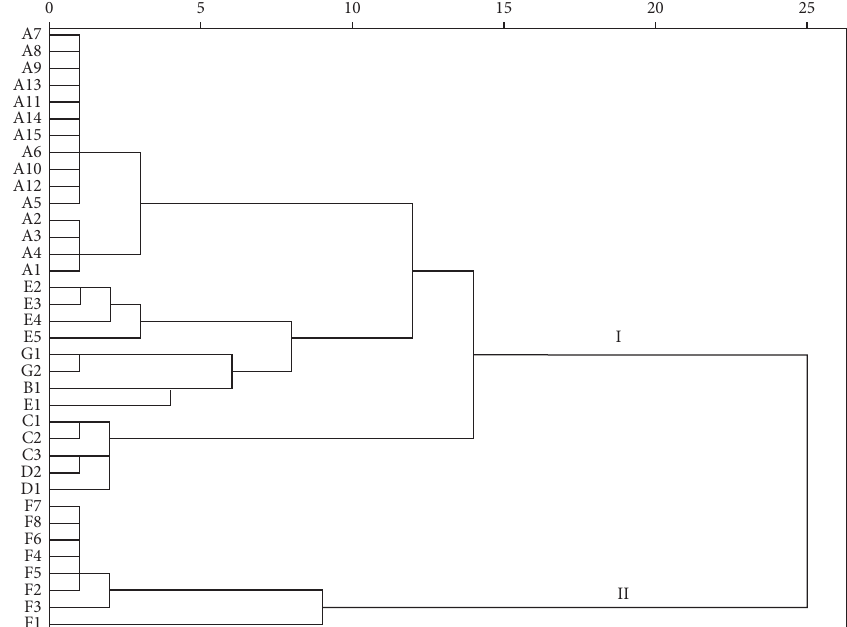
Figure 5: The CA results of different batches of XJC